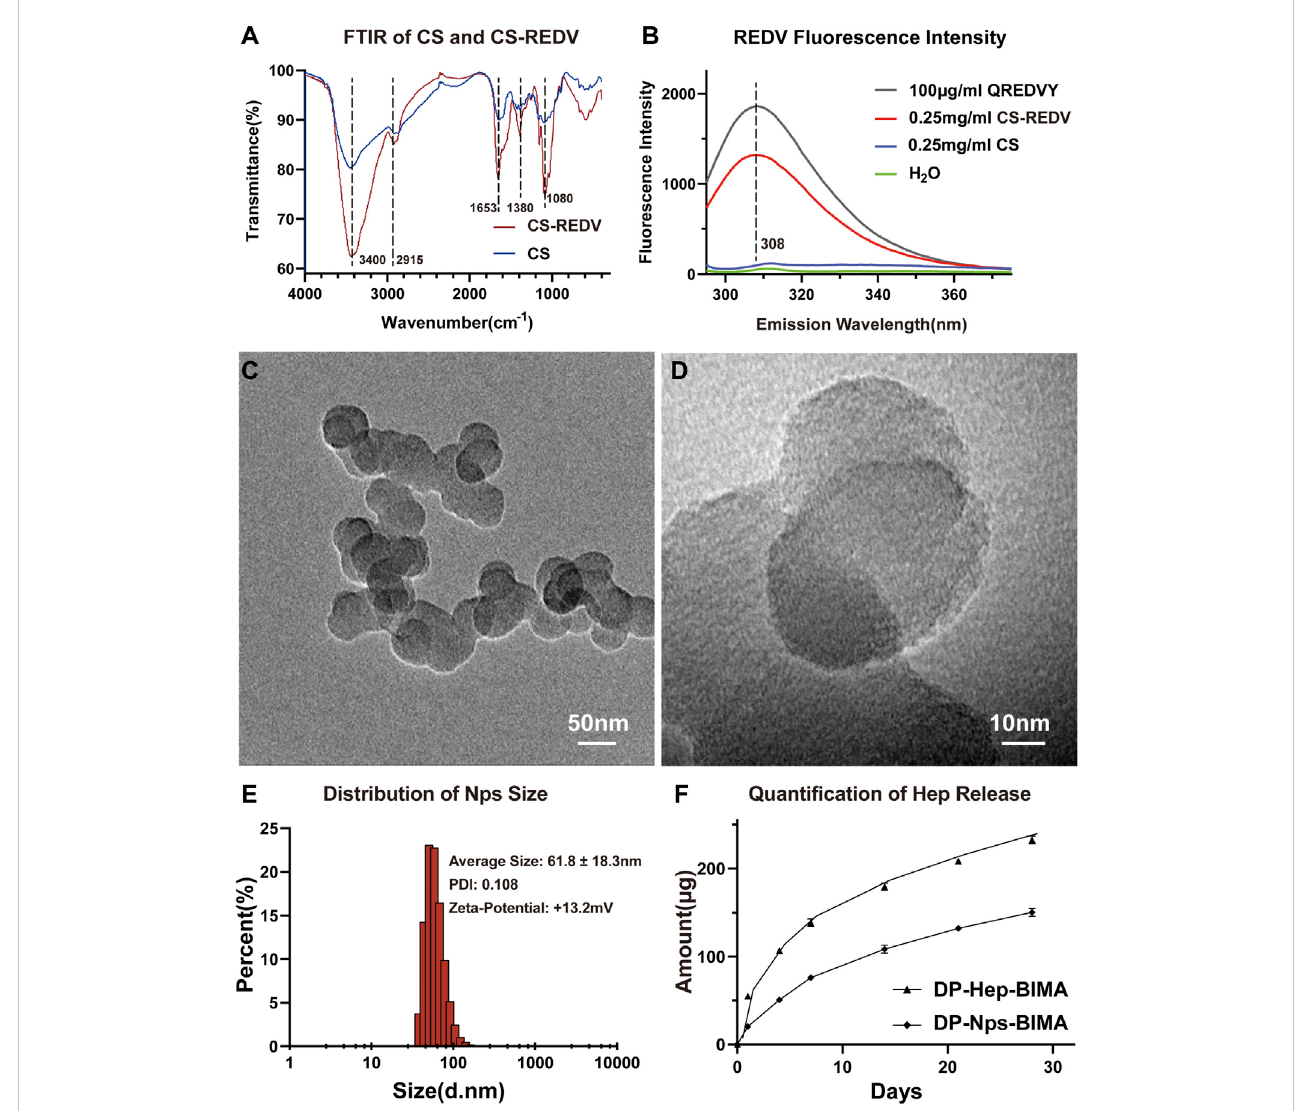
FIGURE 3 The characteristics of CS -REDV -Hep nanoparticles. (A) is the Fourier transform infrared spectroscopy curve of chitosan and CS-REDV copolymers. (B) is the fl uorospectro photometer results of different solutions. H 2 O had no emission wave and was used as a negative control. .25 mg/mL CS solution had no emission wave as well. (C,D) are TEM images of the CS -REDV -Hep nanoparticles. (E) is the characteristics of the nanoparticles ( n = 3). (F) showed the quanti fi cation of heparin release in PBS ( n = 3).